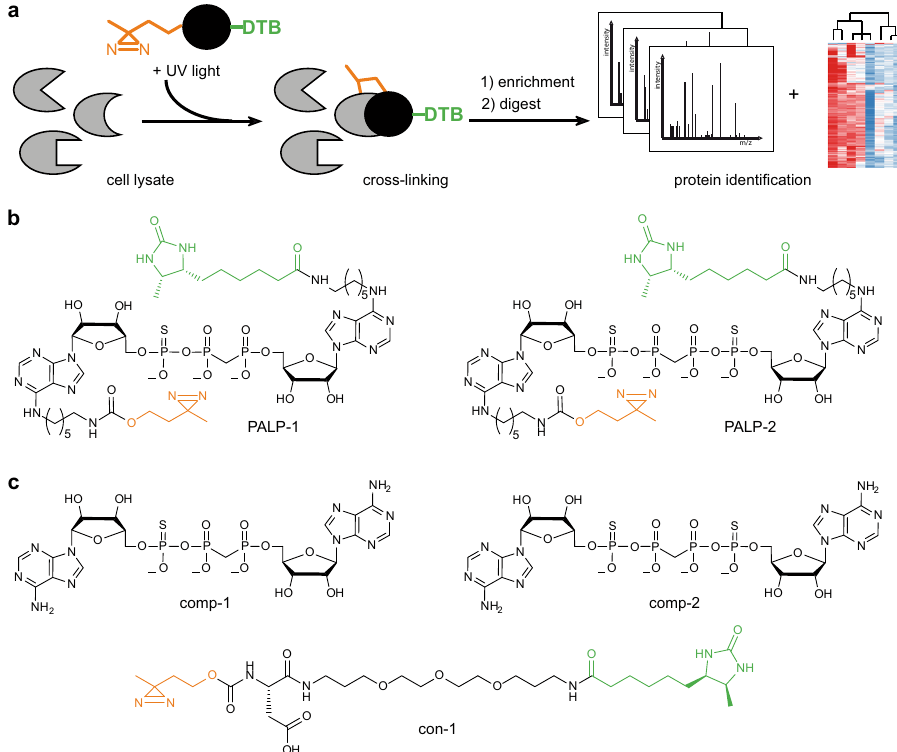
Fig. 1 Overview of photoaf fi nity-labeling (PAL) approach for identifying Ap n A interactors. a Schematic work fl ow of PAL experiments. Probes were incubated with cell lysates and irradiated with UV light to initiate photo-crosslinking. Labeled proteins were af fi nity-puri fi ed using desthiobiotin (DTB) as af fi nity tag. Eluted fractions were digested and analyzed by LC-MS/MS and label-free quanti fi cation (LFQ). b Functionalized, non-hydrolysable Ap 3 A and Ap 4 A derivatives used as PAL probes (PALP). c Unlabeled, non-hydrolysable Ap 3 A and Ap 4 A derivatives and a control substance (con-1) lacking the Ap n A scaffold served as controls in PAL